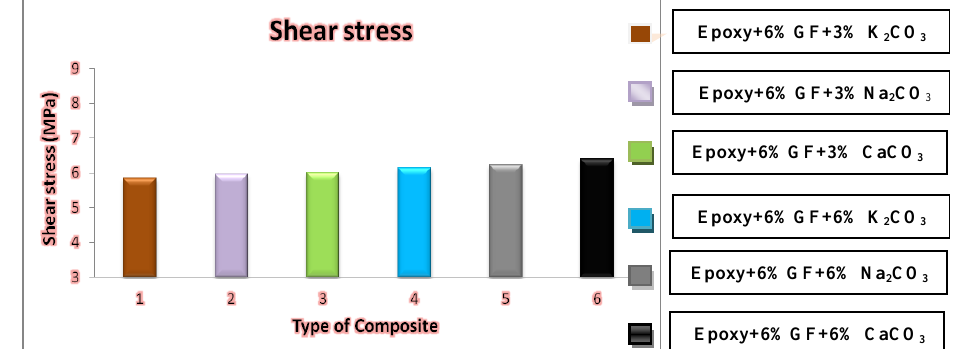
Fig.17: Shear stress of industrial composites